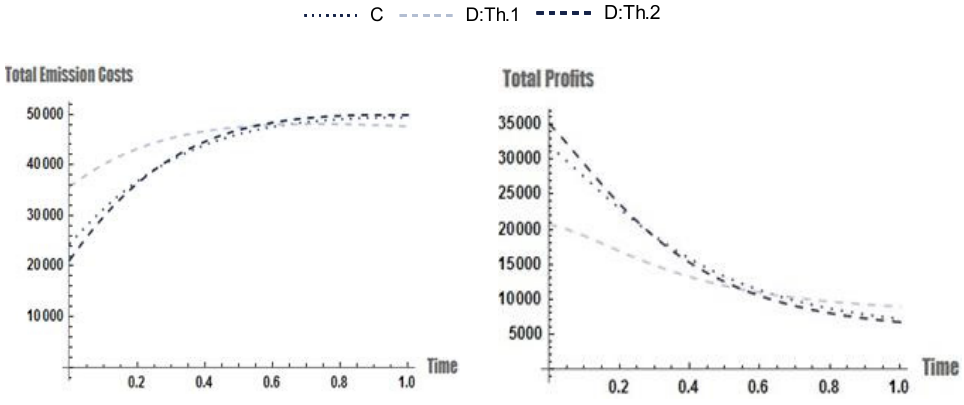
Figure 3. Total profits and emission costs as a function of time.